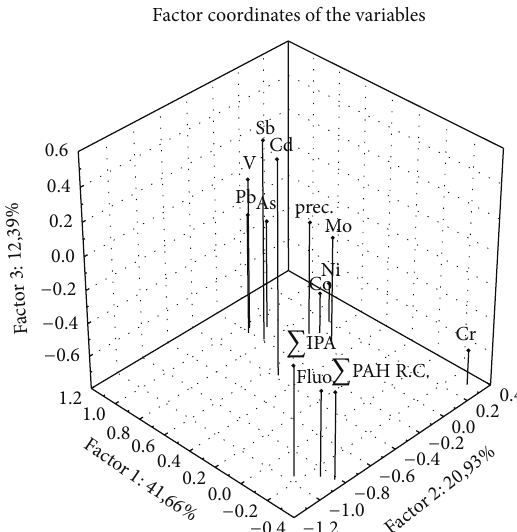
Figure 13: Loading plot 3D of the three first principal components obtained by PCA analysis of fluxes determined in D4.